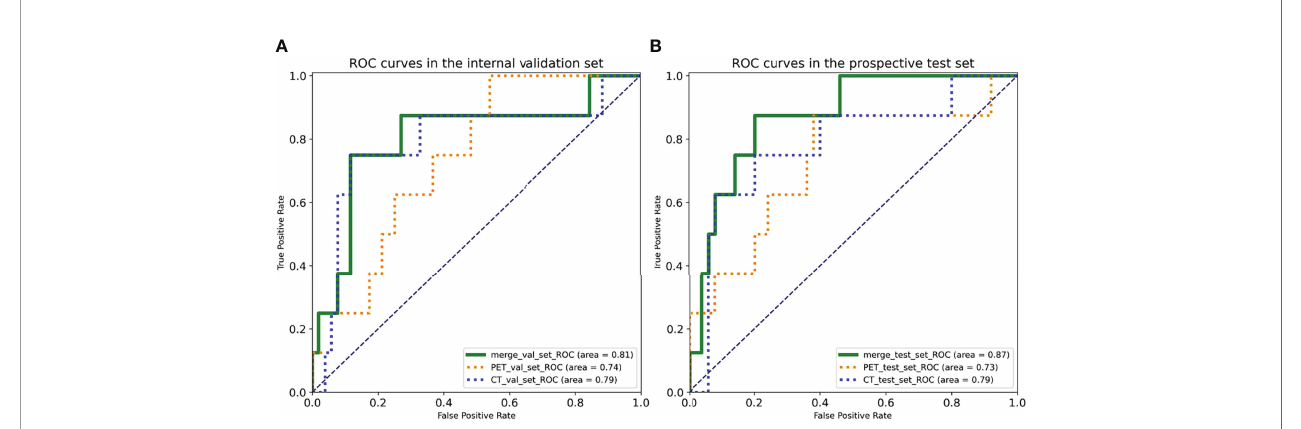
FIGURE 3 | Receiver operating characteristic (ROC) curves of three deep learning models in the (A) internal validation set and the (B) prospective test